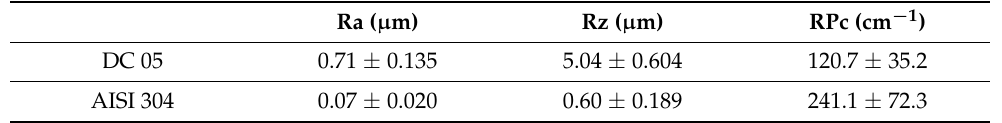
Table 1. Surface roughness parameters for steels DC 05 and AISI